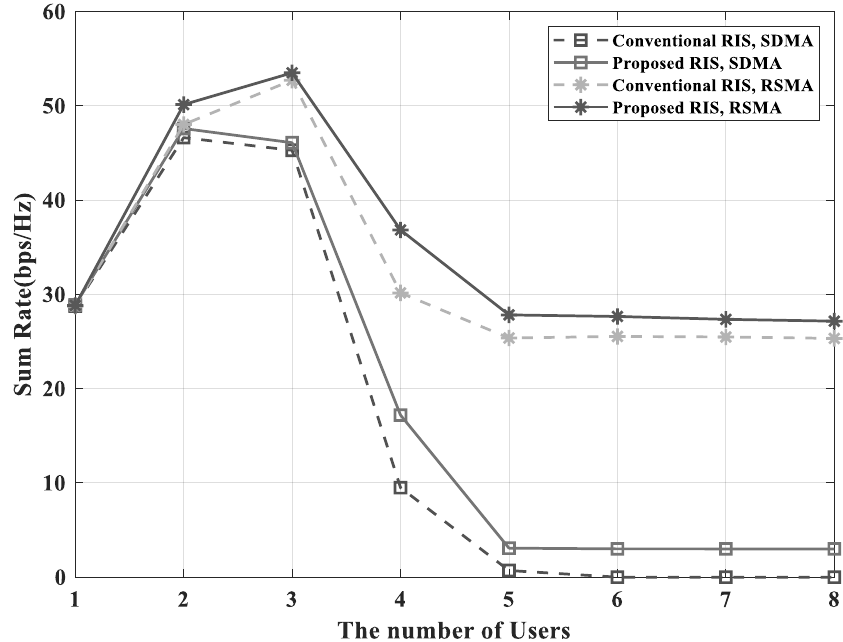
Figure 7. Sum-rate versus the number of users with N G = 8 and N I =